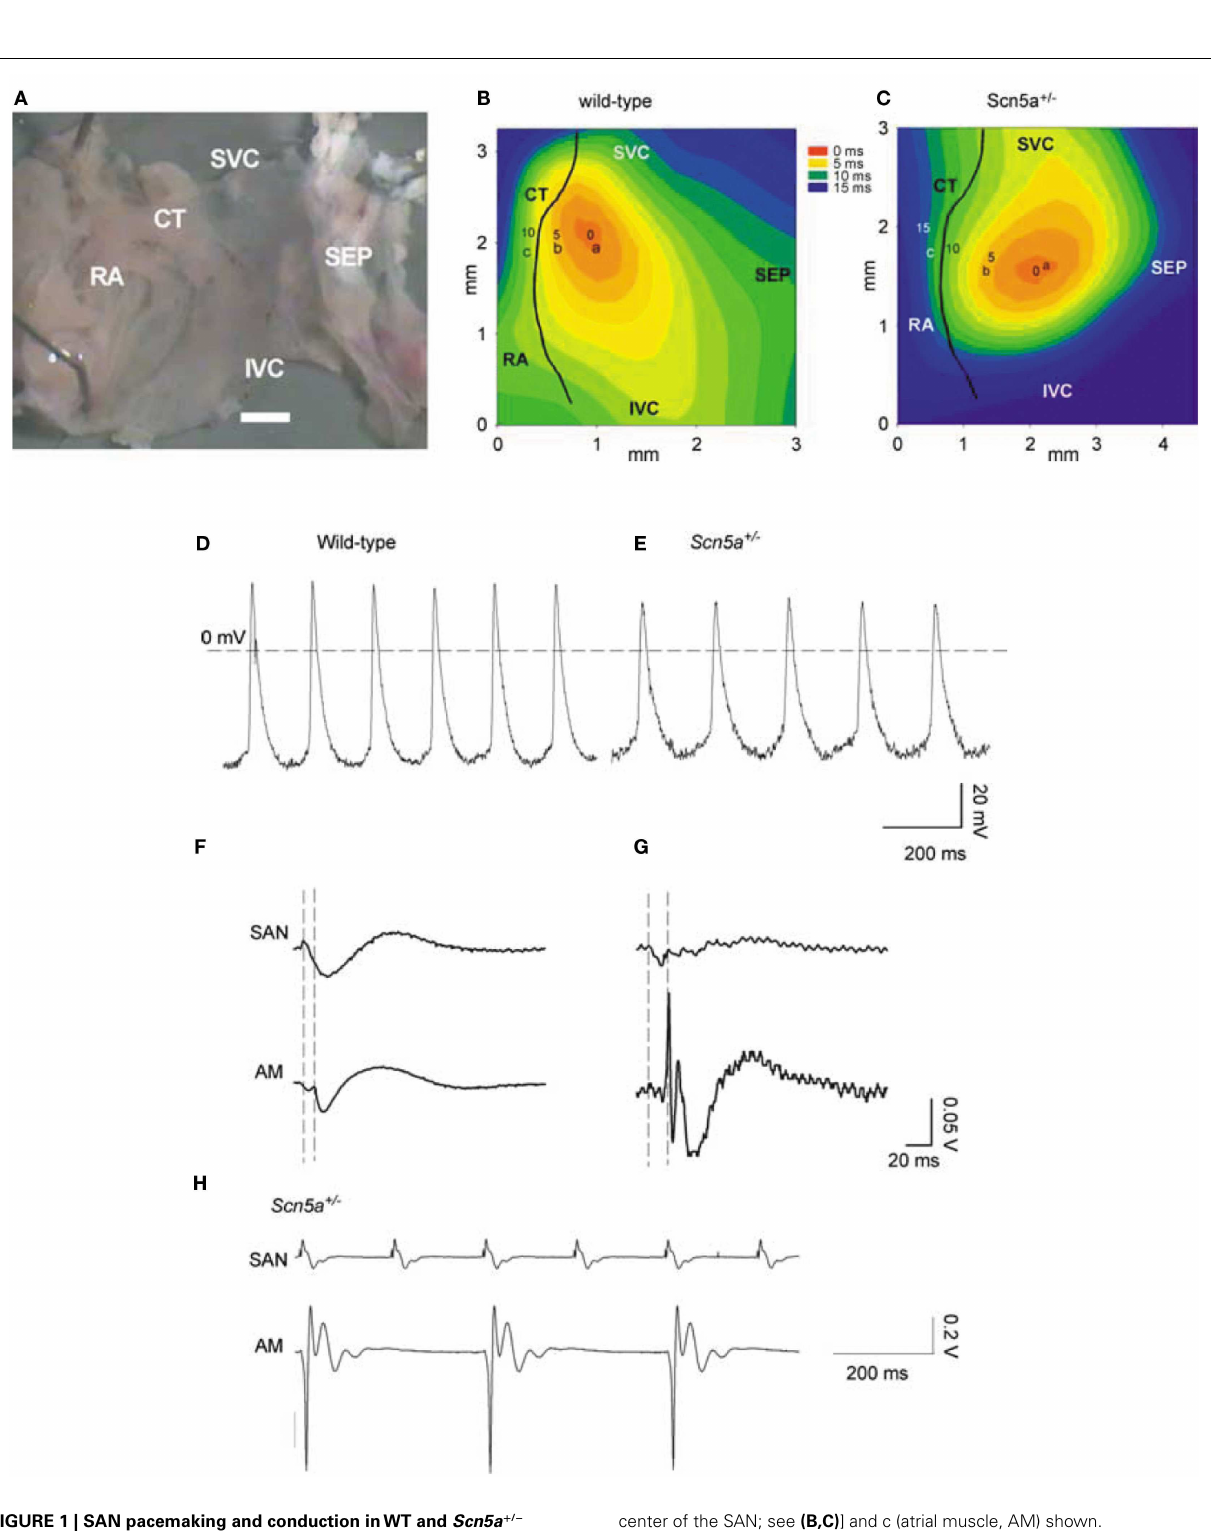
center of the SAN; see (B,C) ] and c (atrial muscle, AM) shown. Vertical dashed lines indicate the time of initiation of the AP at the leading pacemaker site (left) and the arrival of the AP in atrial muscle (right). (H) Simultaneous SAN and atrial muscle recordings showing sino-atrial conduction block in Scn5a + / − SAN, never observed inWT. SEP, septum; SVC, superior vena cava; IVC, inferior vena cava; CT, crista terminalis; and RA, right atrial